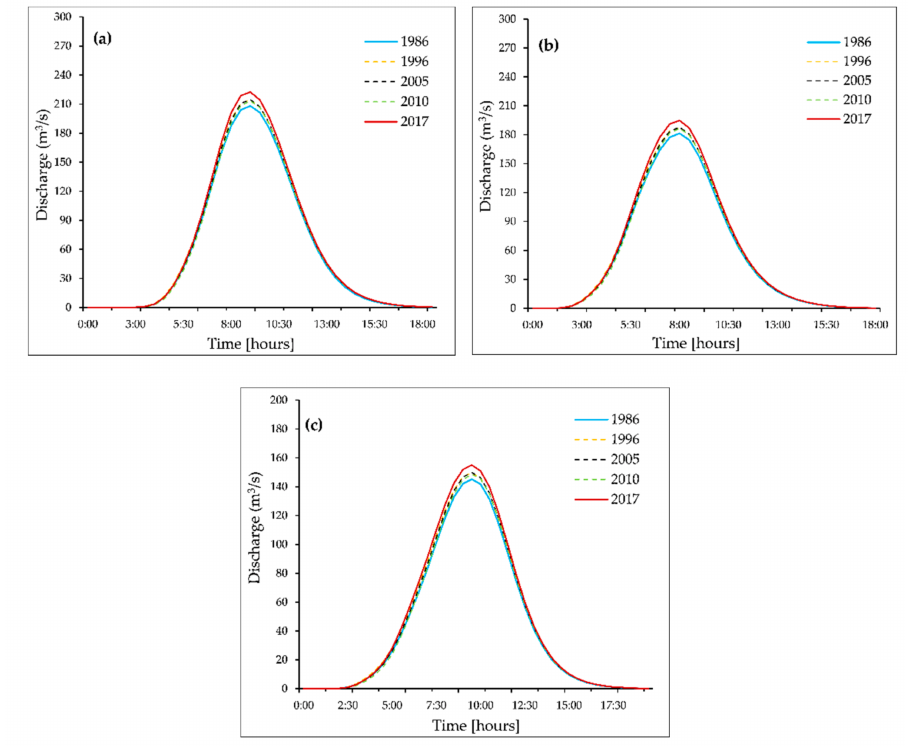
Figure 6. Hydrographs for the land use/cover scenarios of the study catchment under three rainfall events: ( a ) Rainstorm 1, ( b ) Rainstorm 2, and ( c ) Rainstorm